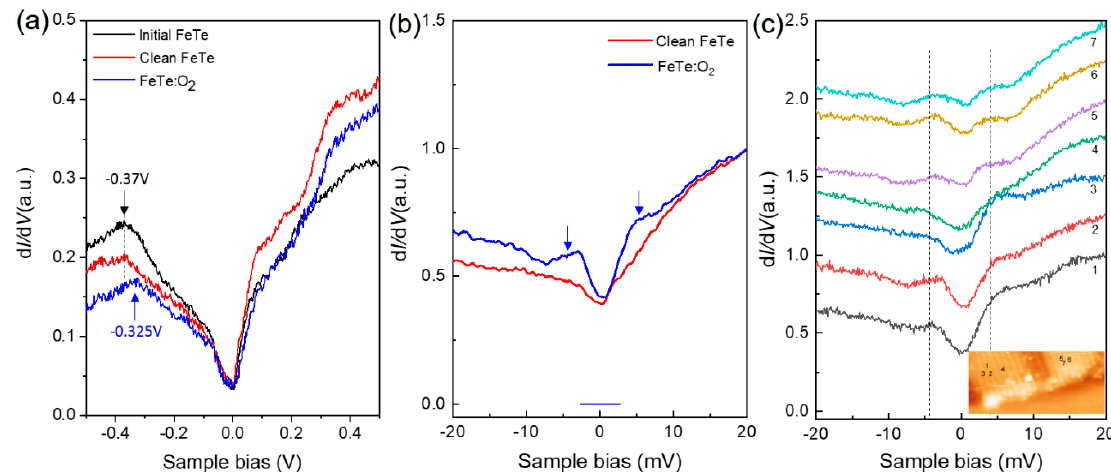
Figure 4. (Color online) ( a ) Typical d I /d V spectra on 10UC FeTe before and after O 2 adsorption. A hump at negative energy shows a clear shift on FeTe : O 2 overlayer. Starting condition: V s = 0.5 V, tunneling current I t = 100 pA. ( b ) The zoomed-in d I /d V spectra on clean FeTe area and FeTe : O 2 overlayer. An energy gap with two pronounced peaks was observed across the Fermi level, which is a superconducting gap. Starting condition: V s = 20 mV, tunneling current I t = 200 pA. ( c ) A series of d I /d V spectra on FeTe : O 2 , showing the energy gap can be observed on the whole FeTe : O 2 islands. Starting condition: V s = 20 mV, tunneling current I t = 200